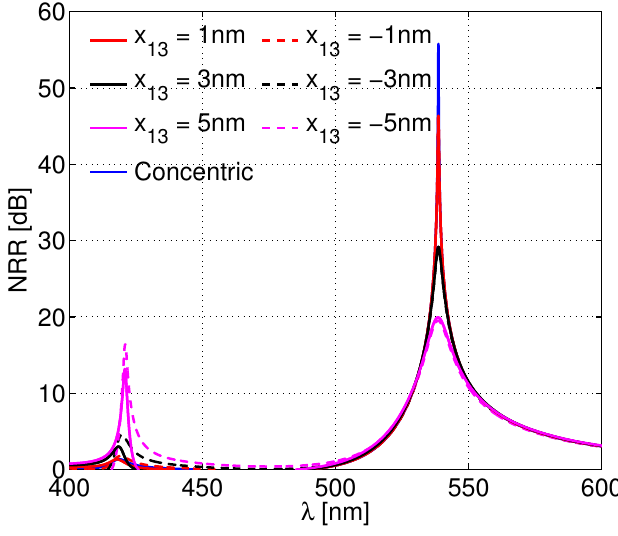
Figure 2. The normalized radiation resistance (NRR) as a function of the excitation wavelength λ for the investigated 3L NPs. The results are recorded for κ = − 0 . 4409 , which optimizes the NRR of the concentric 3L NP in the dipole mode operation; concentric and eccentric cases are shown.